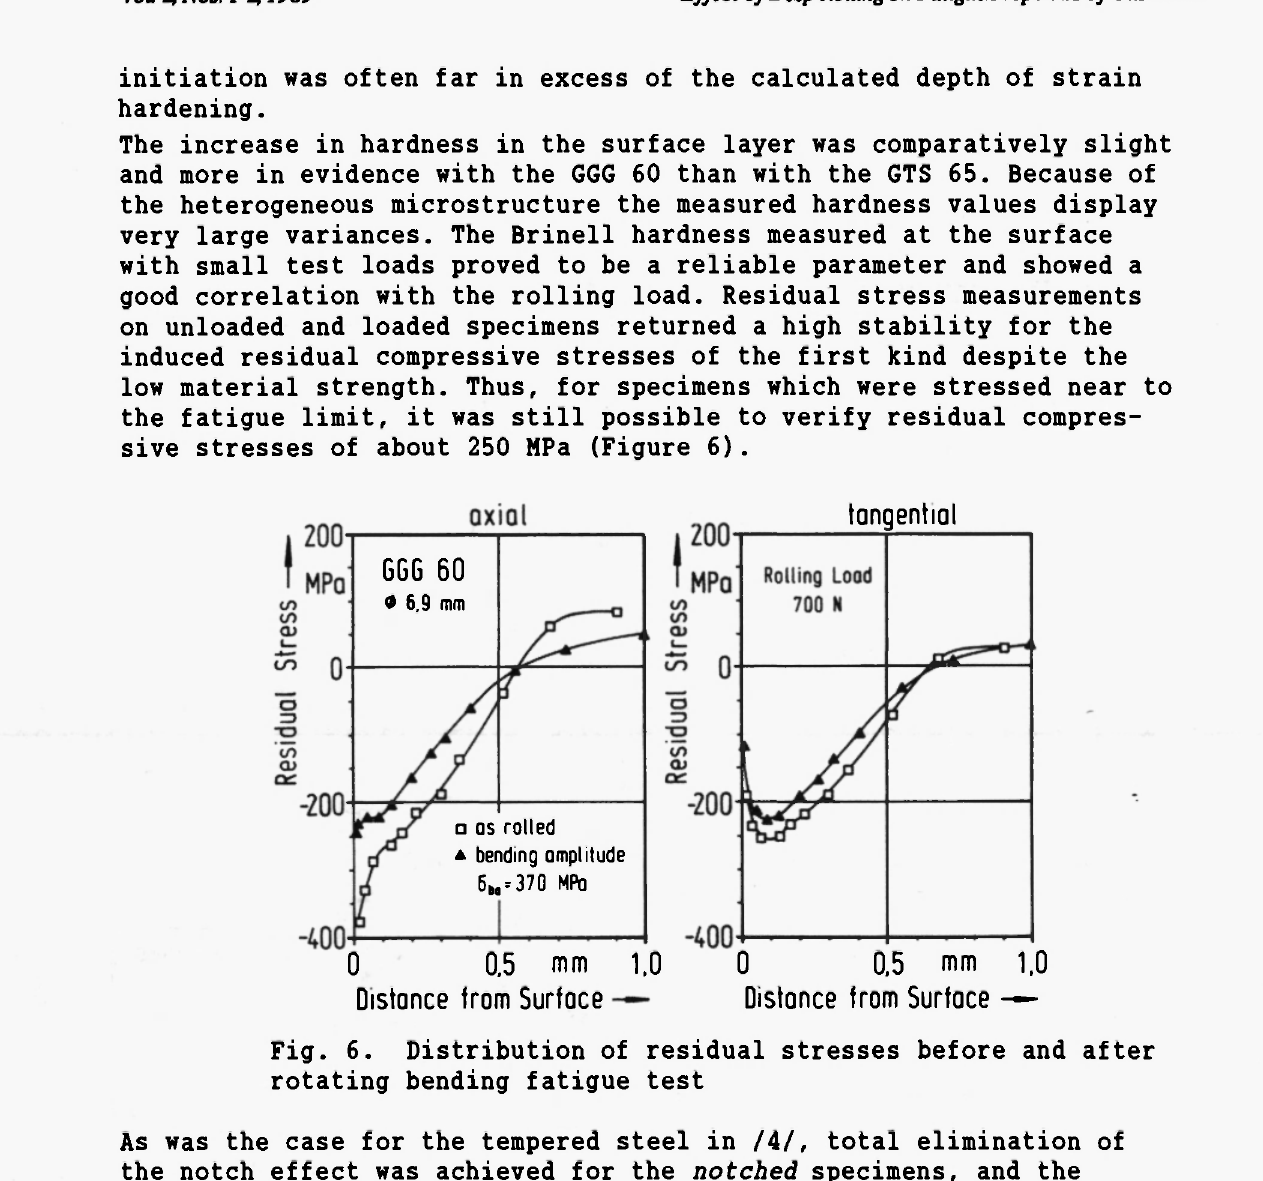
Fig. 6. Distribution of residual stresses before and after rotating bending fatigue